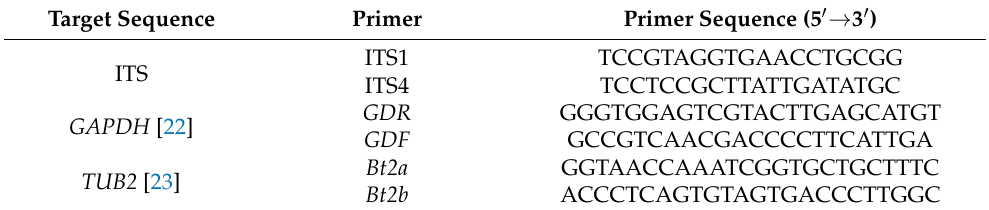
Table 1. PCR primers for ITS, GAPDH, and β -TUB